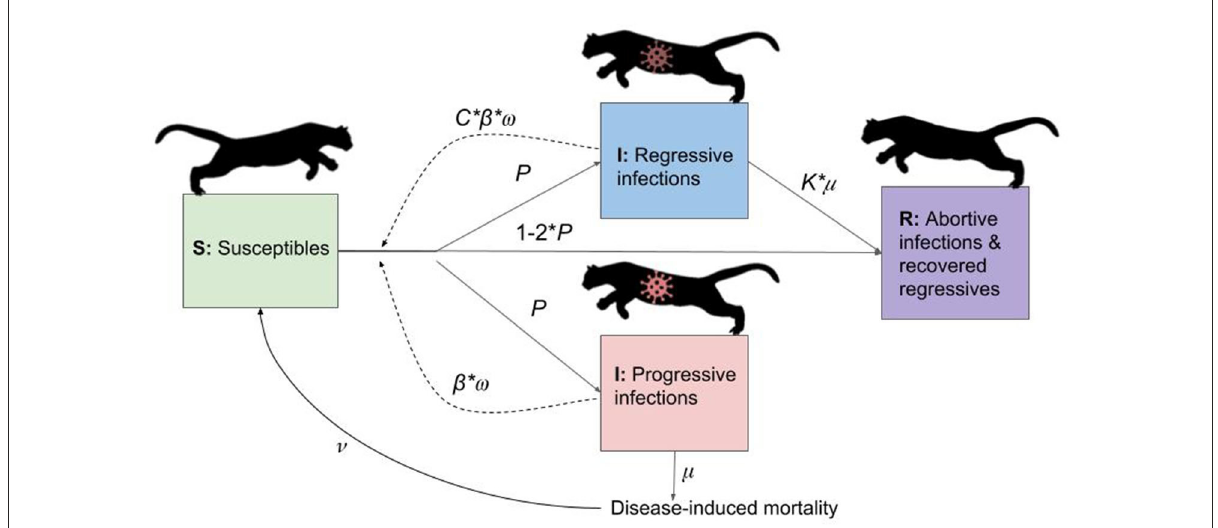
FIGURE2 Diagram of flows of individuals between compartments in the transmission model. Virus icons indicate infectious states, with the regressive infection icon darkened to represent reduced or uncertain infectiousness of this class. Note: a vaccination process was also included in the transmission model, but is not shown for simplicity. With vaccination, susceptibles could be vaccinated, and vaccinated individuals subsequently infected as with susceptibles, but with an additional probability of (1-ve). See Supplementary Table S1 for definitions of